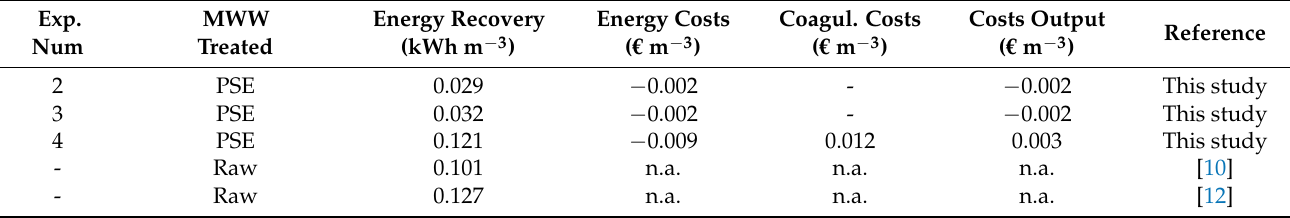
Table 6. Energy and operating cost of DM